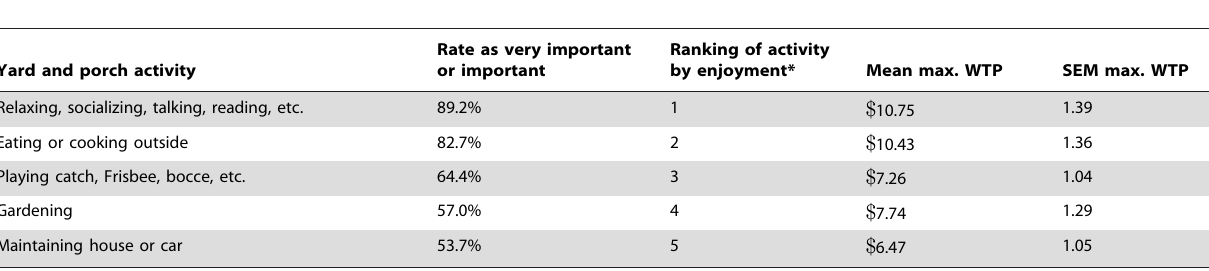
Table 3. Enjoyment associated with yard and porch activities and willingness to pay (WTP) for one additional work-free, mosquito- free hour per summer week engaged in each of these